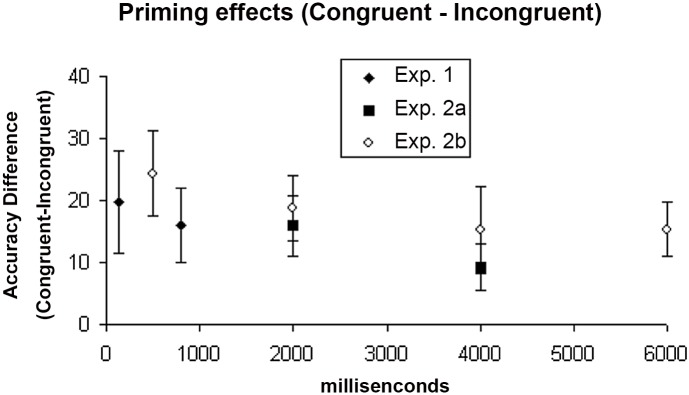
The priming effects of Exp. 1, 2A, and 2B.The priming effect indicated as the accuracy difference between the congruent and incongruent conditions across Experiment 1, 2A, and 2B, instead of difference between congruent and control conditions due to the lack of control conditions under several ISIs. From the figure, it was clear there was a such tendency that priming effect decayed with as the ISI increased, but such decay was small and smooth. The priming effect was smaller but more stable after a few seconds. Error bars show standard error of mean (SEM).